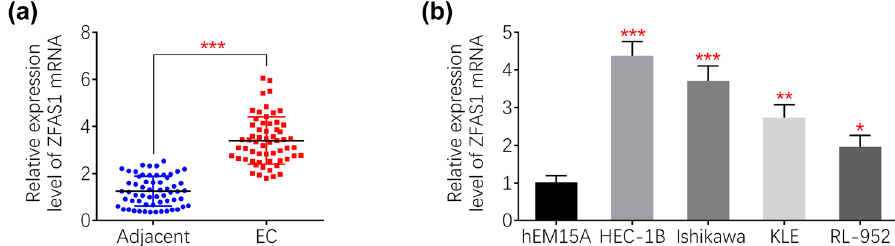
Figure 1: Elevated ZFAS1 in endometrial carcinoma. ( a ) ZFAS1 was enhanced in the endometrial carcinoma tissues compared to adjacent tissues. ( b ) ZFAS1 was enhanced in the endometrial carcinoma cell lines ( HEC - 1B, Ishikawa and KLE, RL - 952 ) compared to hEM15A.